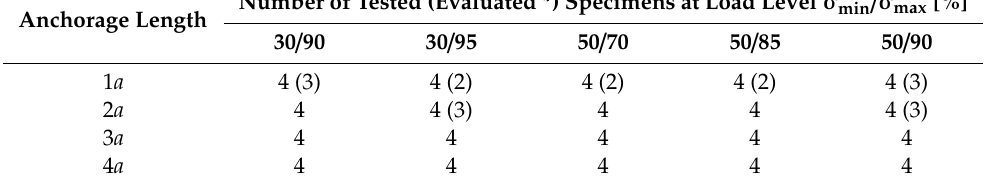
Table 1. Experimental